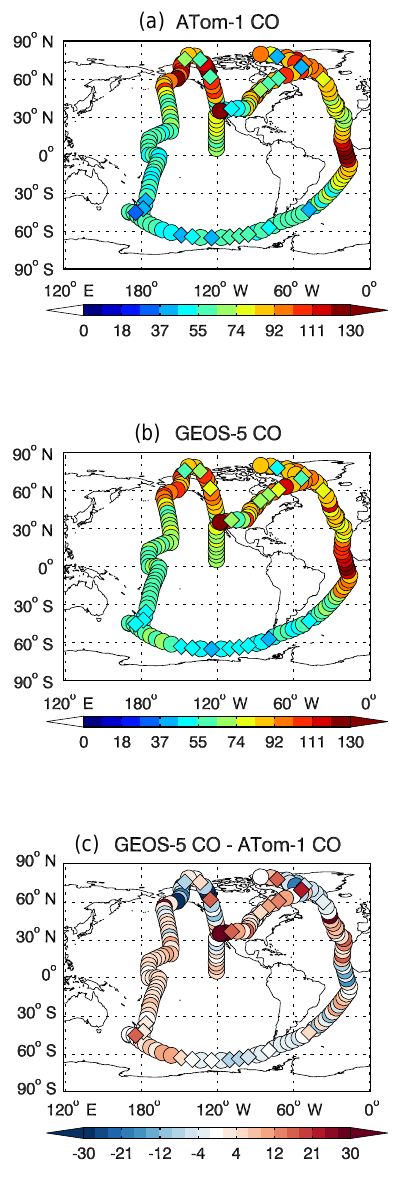
Figure 4. CO (ppb) from the (a) QCLS observations, (b) GEOS-5 analysis, and (c) the GEOS-5–observation difference for the ATom- 1 circuit including all 11 research flight segments. The GEOS-5 CO is taken from the analysis closest to the midpoint of the flight time and interpolated to the flight track following the longitude, latitude, and pressure given in the observations. Both model forecast and ATom measurements are averaged into a sample rate of one per 360s. Data in the troposphere are plotted in a circle, while data in the stratosphere are plotted in a diamond, based on the GEOS-5